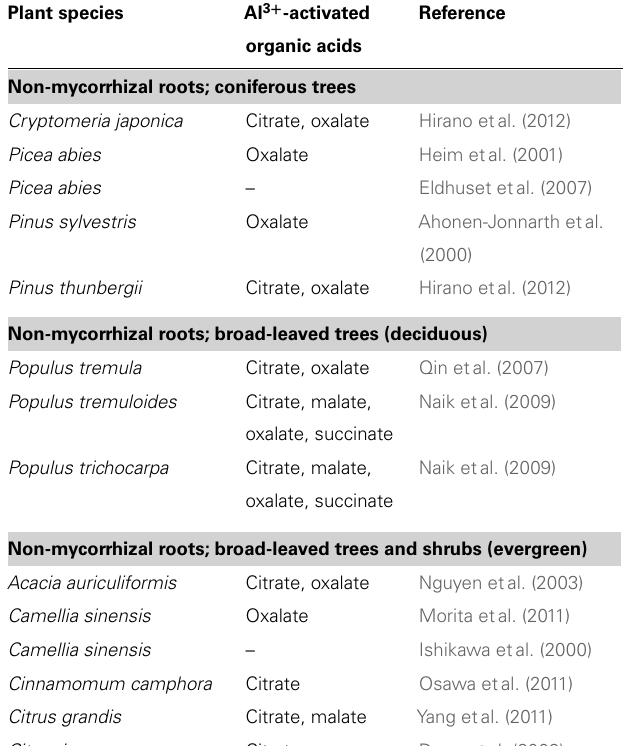
Table 2 |Al 3 + -activated release of organic acids from roots of woody